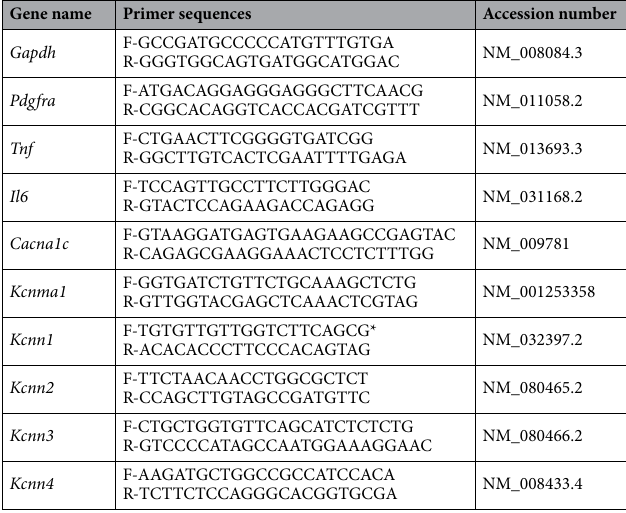
Table 1. Primer sequences used for